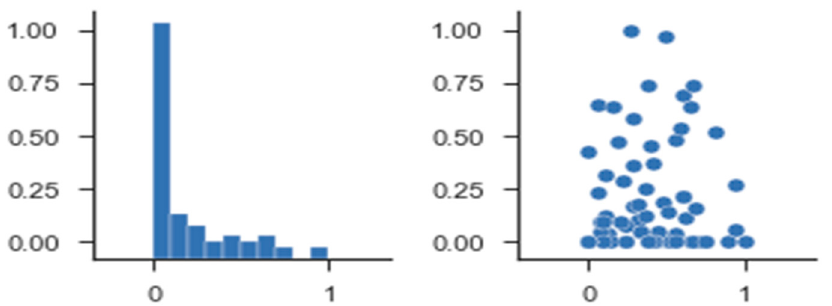
Figure 11. The visualization of top driver’s accident records.